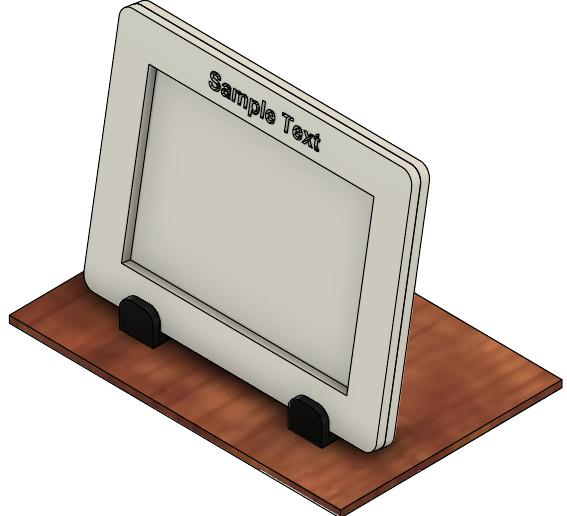
Figure 5. Objective of the Case Study